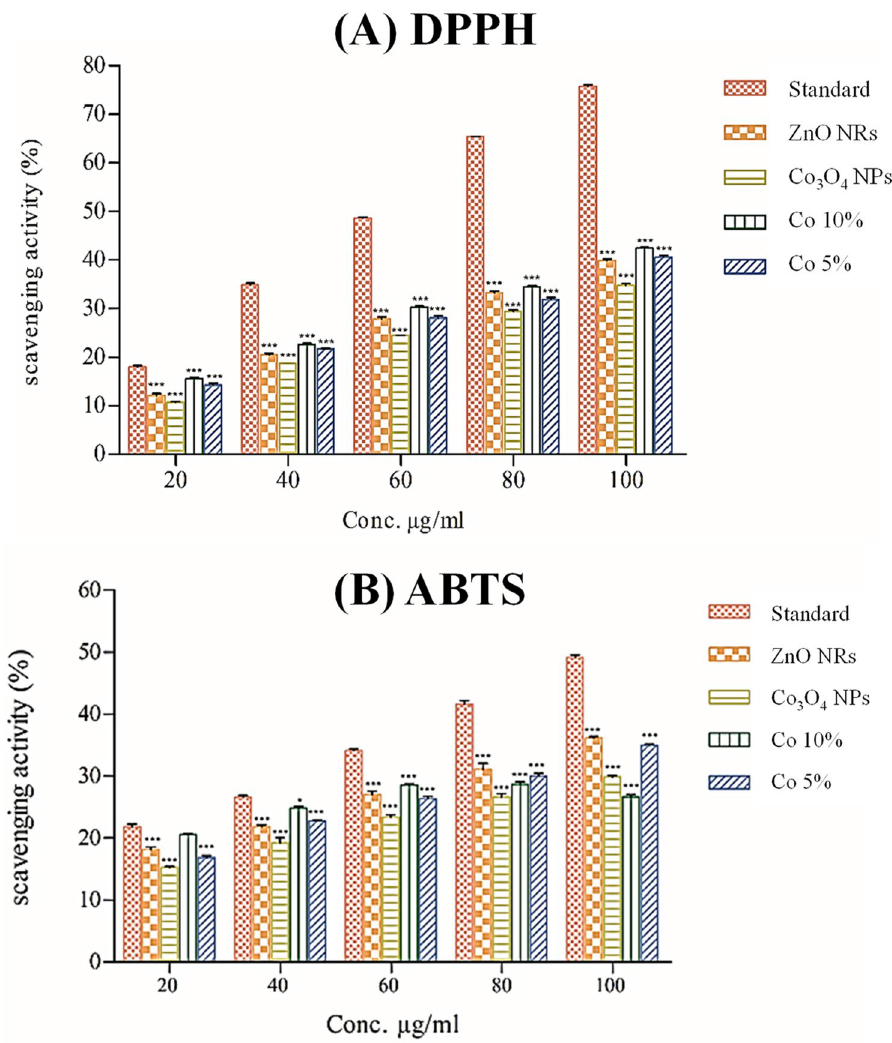
Figure 13. Comparative study antioxidant of activity using ( A ) DPPH and ( B ) ABTS radical scavenging potential with different concentrations of Standard, ZnO NRs, Co 3 O 4 NPs, Co 10% and Co 5% nanocomposite. (n = 3). Data represent the mean ± SD; N = 3. * P < 0.01, ** P < 0.001, *** P < 0.0001 compared with